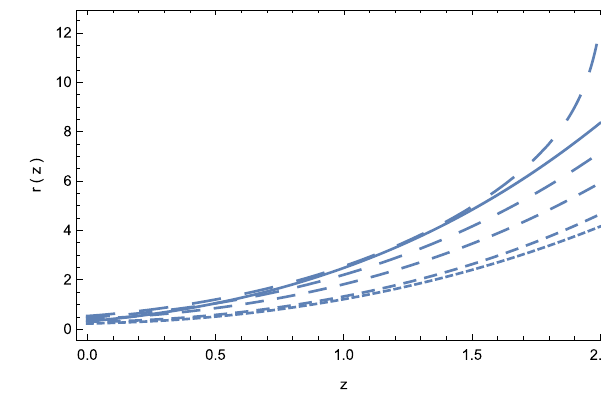
Fig. 5 Variation as a function of the redshift of the dimension- less Hubble function h ( z ) for the geometry-matter coupling function (cid:12) (cid:11) ˜ Q , ˜ T = α ˜ Q ˜ T for M = 0 . 98, and for different values of α : F α = − 0 . 72(dottedcurve), α = − 0 . 77(shortdashedcurve), α = − 0 . 80 (dashed curve), α = − 0 . 81 (long dashed curve), and α = − 0 . 82 (ultra- long dashed curve). To integrate the system of cosmological evolution equations we have used the initial conditions h ( 0 ) = 1, (cid:18)( 0 ) = 0 . 455, and (cid:4)( 0 ) = 0 . 335. The solid curve represents the evolution of the Hubble function in the standard (cid:4) CDM cosmological model